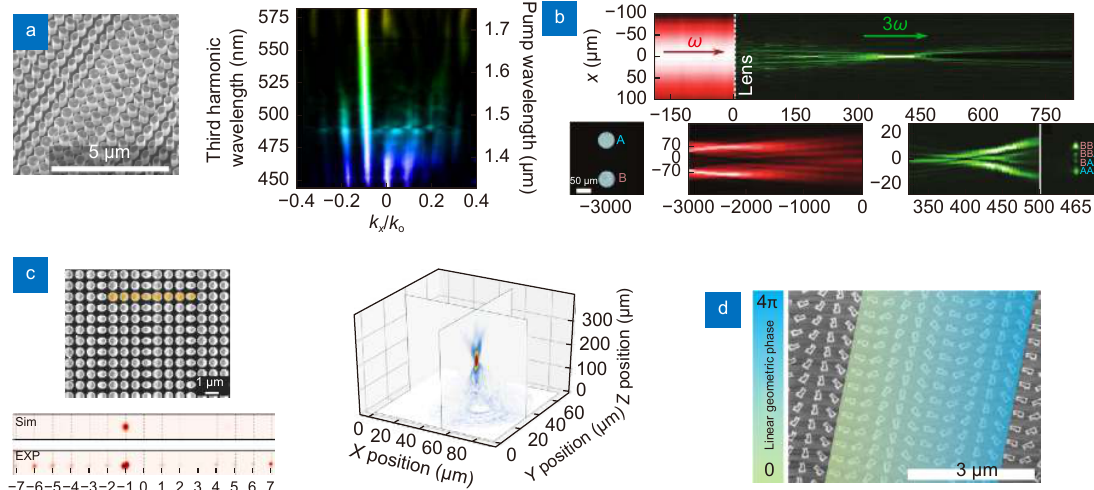
Fig. 4 | Nonlinear wavefront shaping in dielectric metasurfaces. ( a ) Si metasurface implementing the first Kerker condition and funneling THG into the (-1)-diffraction order 106 . ( b ) Top: TH focusing from a Si metasurface. Bottom: Nonlinear imaging and spatial correlation for two aper- tures 107 . ( c ) SH beam-steering (left) and focusing (right) from an AlGaAs metasurface 108 . ( d ) SH geometric phase control in a Si metasurface 109